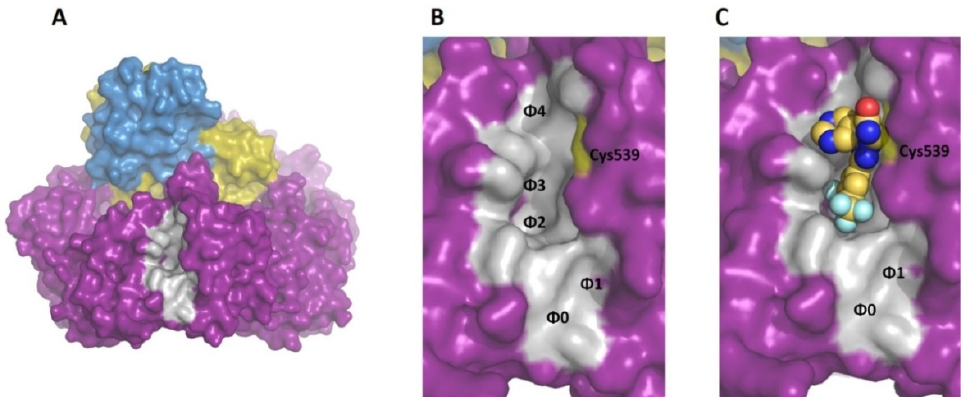
Figure 2. ( A ) Overall structure of the XPO1 protein (in deep purple), Ran (olive) and RanBP1 (sky blue). The NES-binding cleft is shown in grey. ( B ) Surface representation of the NES-binding cleft (grey) and the Φ 0– Φ 4 pockets. ScCys539 is shown in yellow and labelled. ( C ) Detailed view of KPT-8602 (yellow spheres, pdb id: 5jlj) inside of the NES-binding cleft.